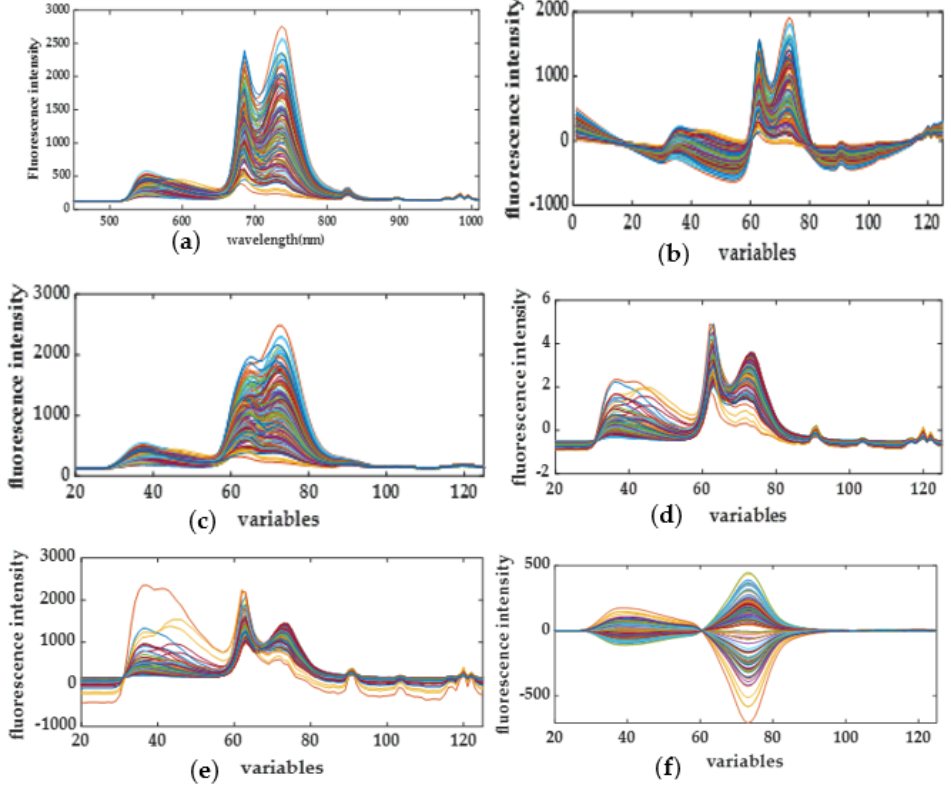
Figure 4. ( a ) Raw hyperspectral fluorescent images; ( b ) DT preprocessing of spectral images; ( c ) S- G preprocessing of spectral images; ( d ) SNV preprocessing of spectral images; ( e ) MSC preprocessing of spectral images; ( f ) OSC preprocessing of spectral images.